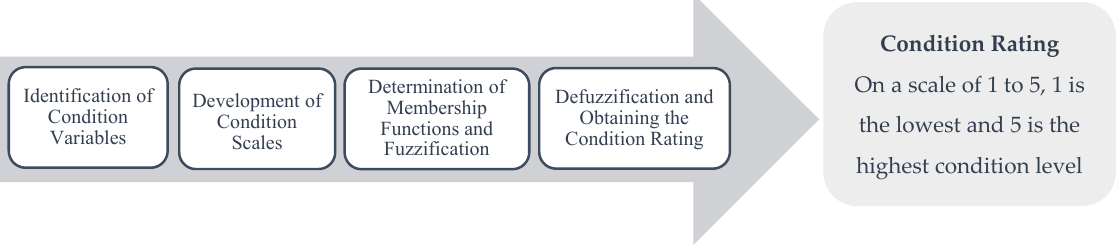
Figure 1. Methodology of the proposed CA framework based on fuzzy sets theory.